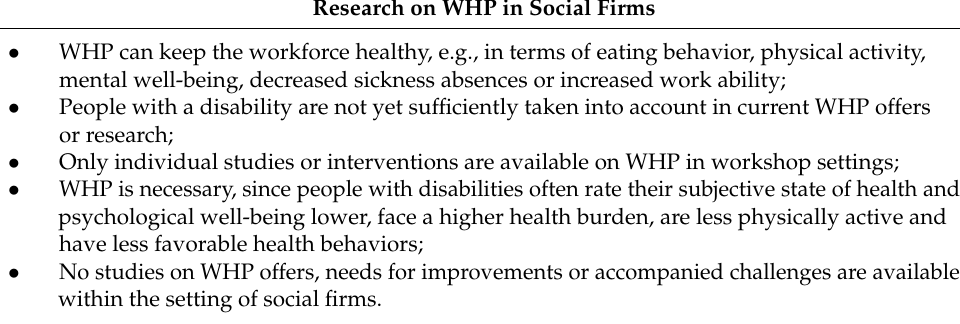
Table 1. Current research on WHP in social